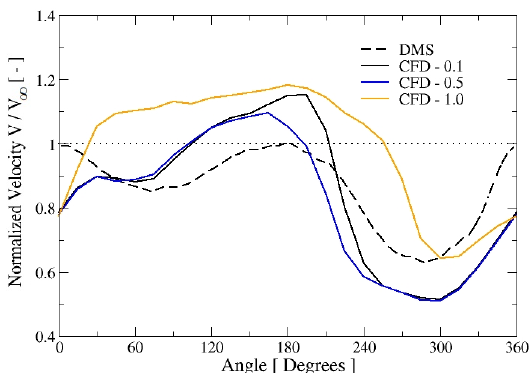
Figure 18. Non-dimensional average velocity along the blades trajectory. Comparison between the CFD averaged results and those provided by the DMS approach. See text for details.